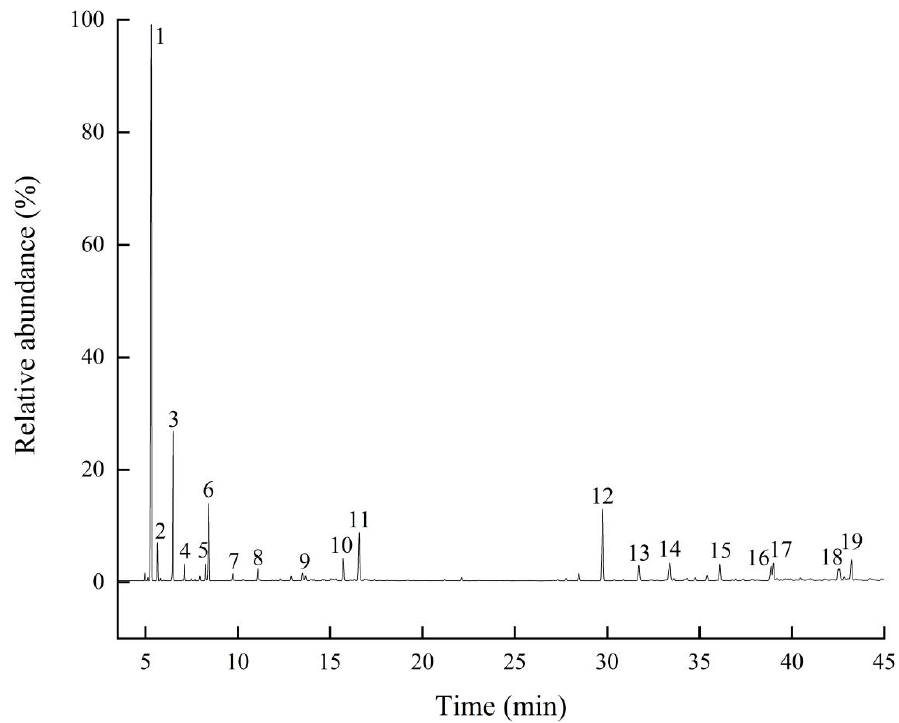
Figure 4. Chromatographic profile of the volatile oil from the surface dead fuel. 1, α -pinene; 2, camphene; 3, β -pinene; 4, β -myrcene; 5,limonene; 6, γ -terpinene; 7, terpinolene; 8, β -caryophyllene; 9, humulene; 10, germacrene D; 11, δ -cadinene; 12, p-cymene; 13, pinocarveol; 14, terpinen-4-ol; 15, α -terpineol; 16, spathulenol; 17, caryophyllene oxide; 18, τ -cadinol; 19, α -cadinol.